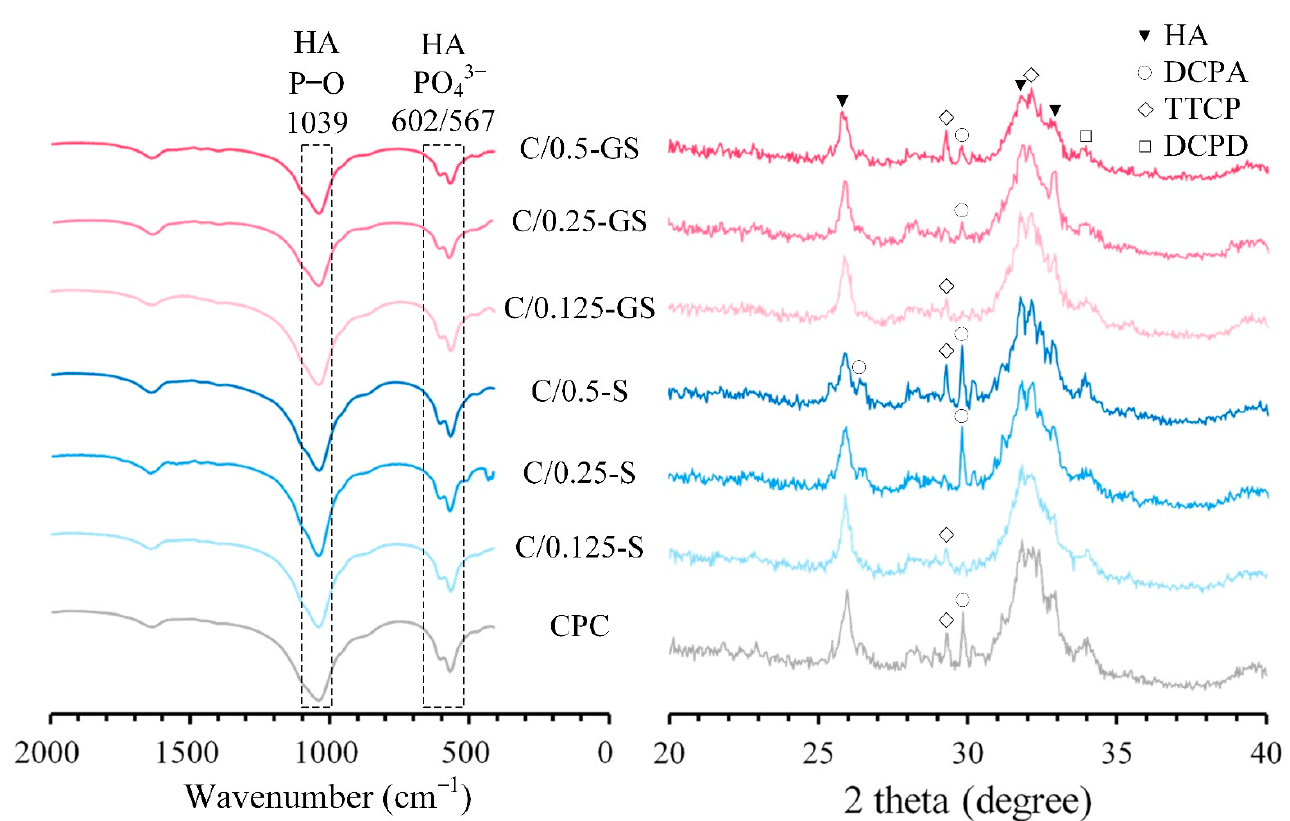
Figure 4. FTIR ( left ) and XRD ( right ) results of CPC/hydrogel composites after immersion in Tris-buffer solution for 1 day.